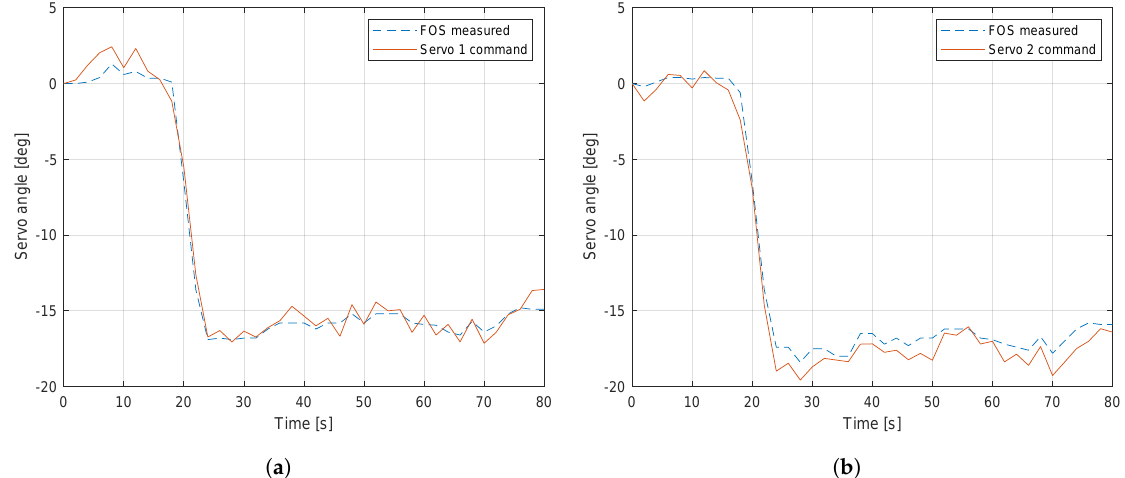
Figure 15. Estimated position with respect to module #6 deflections for the F y = 30 and M x = 0 case. The positions of actuators 1 and 2 are separated and shown in ( a , b ),